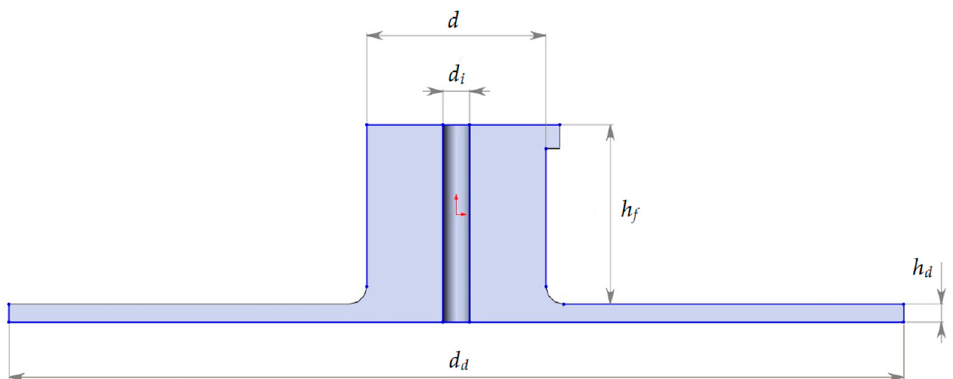
Figure 2. SVT geometric parameters.